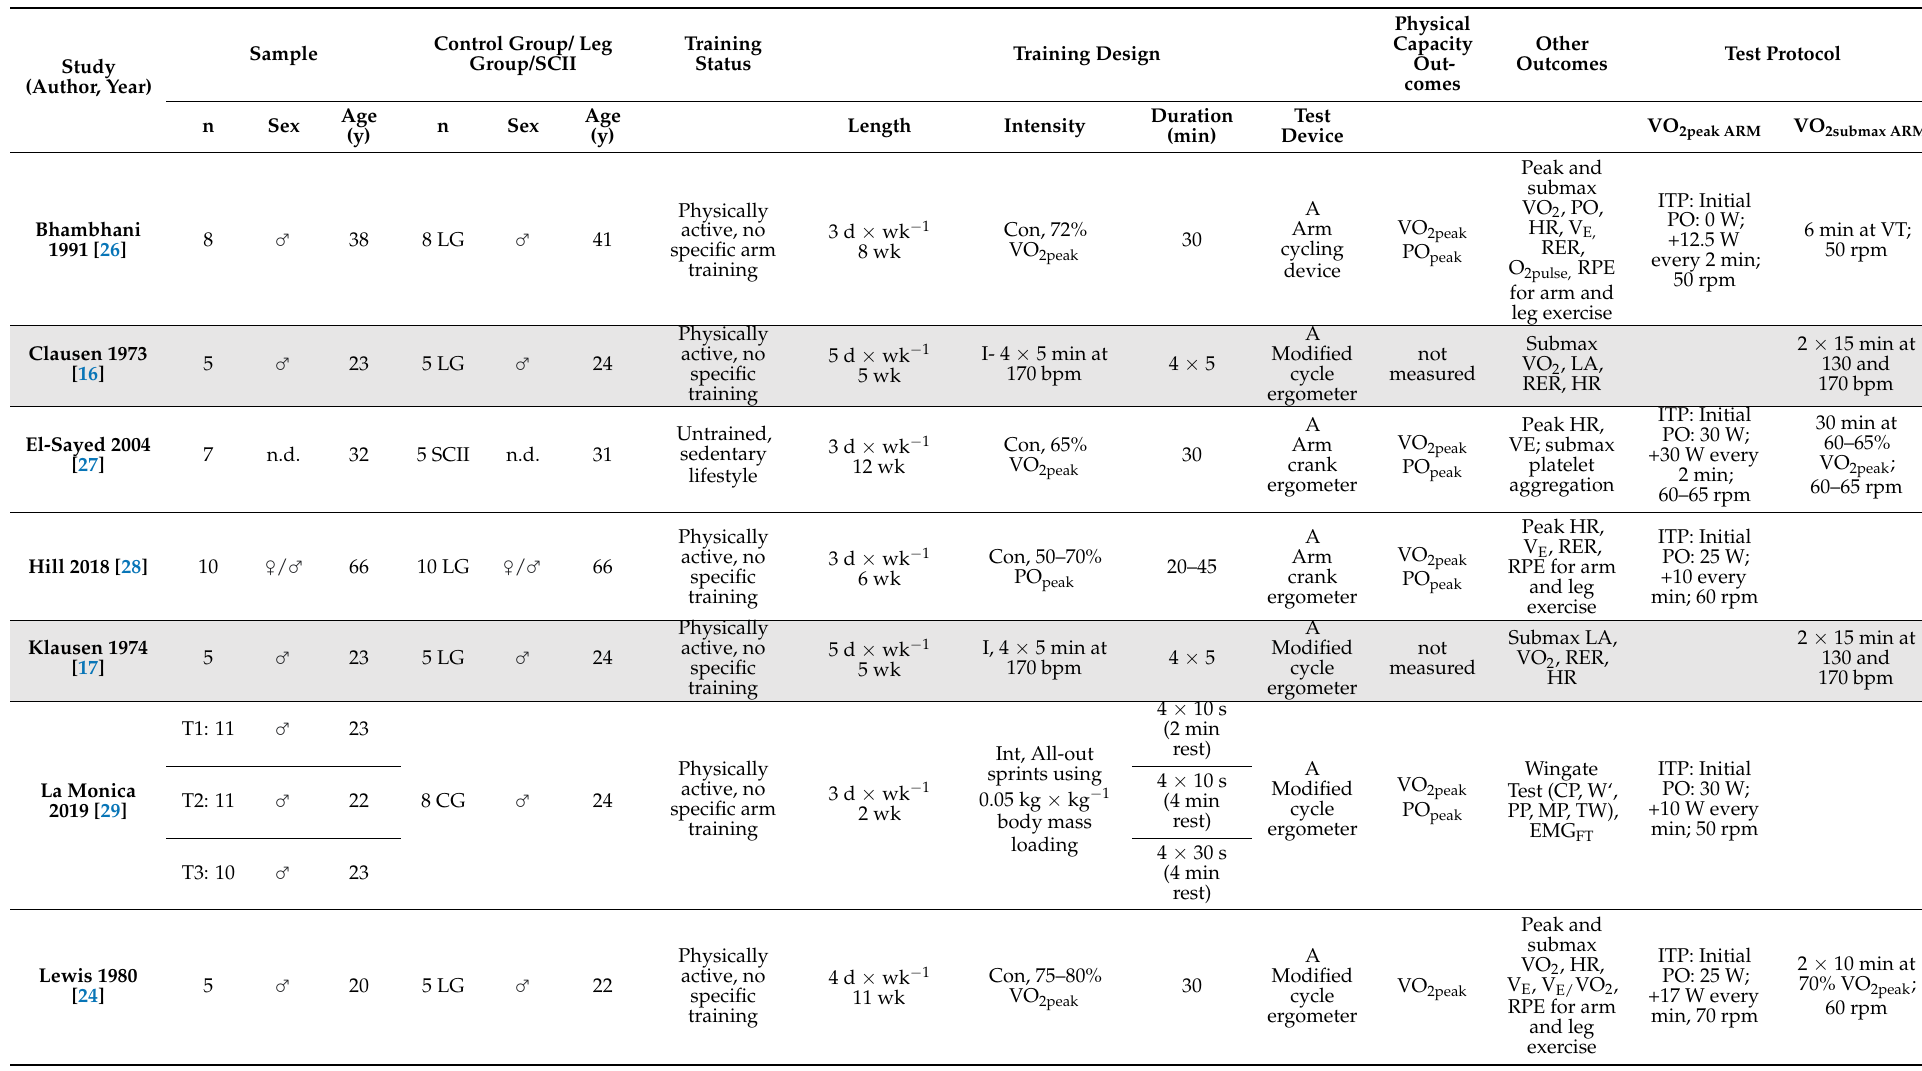
Table 1. Characteristics of studies evaluating the effects of arm crank exercise (ACE) on aerobic